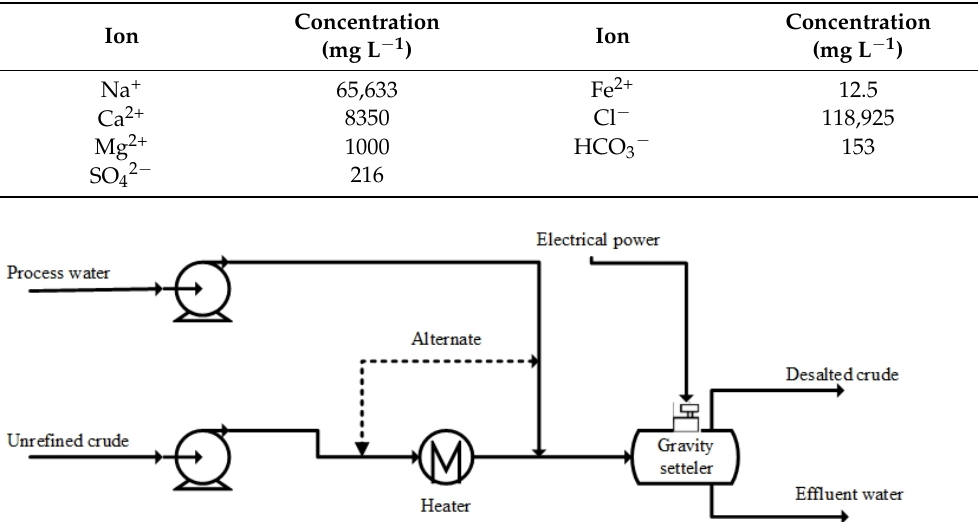
Table 1. Salt concentration in desalting wastewater for Dehluran oil field, Iran [3].